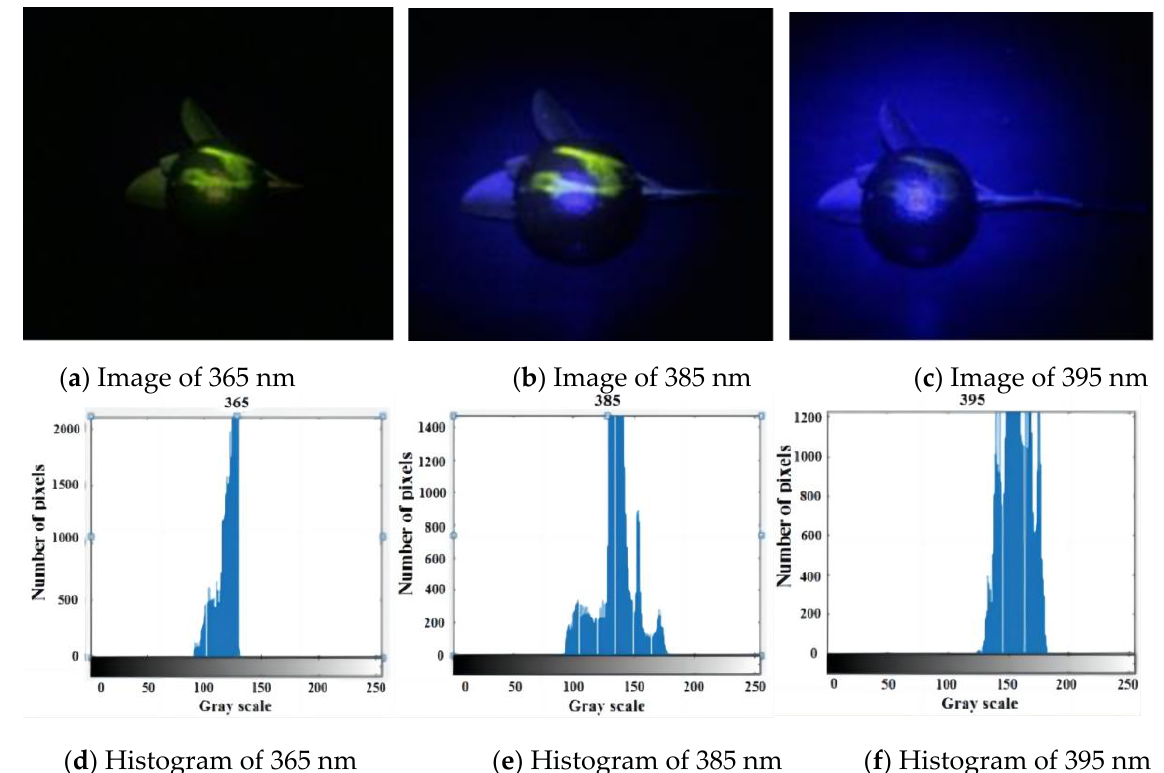
Figure 1. Detection effect and histogram of a component of different wavelengths.